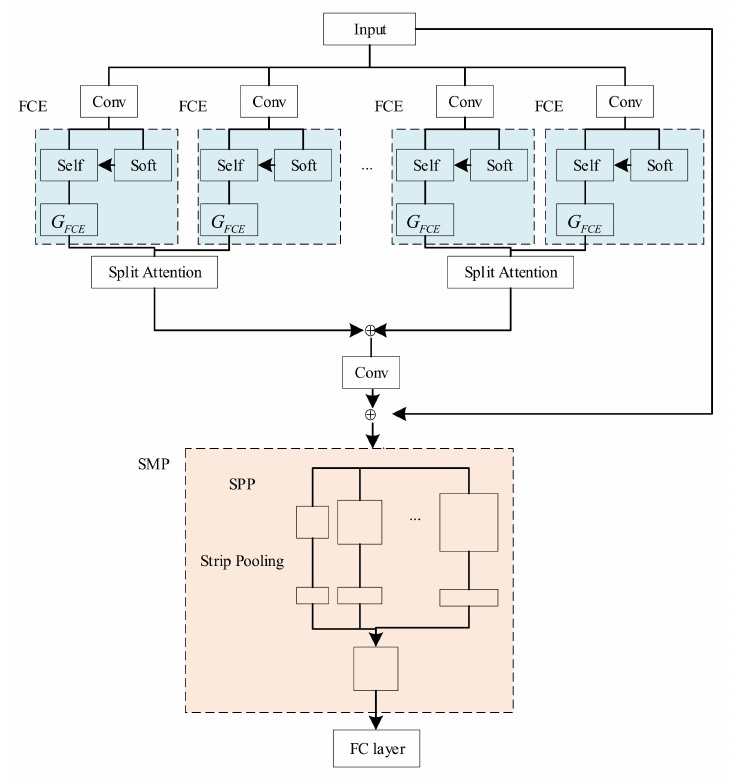
Figure 1. AttNeSt network structure